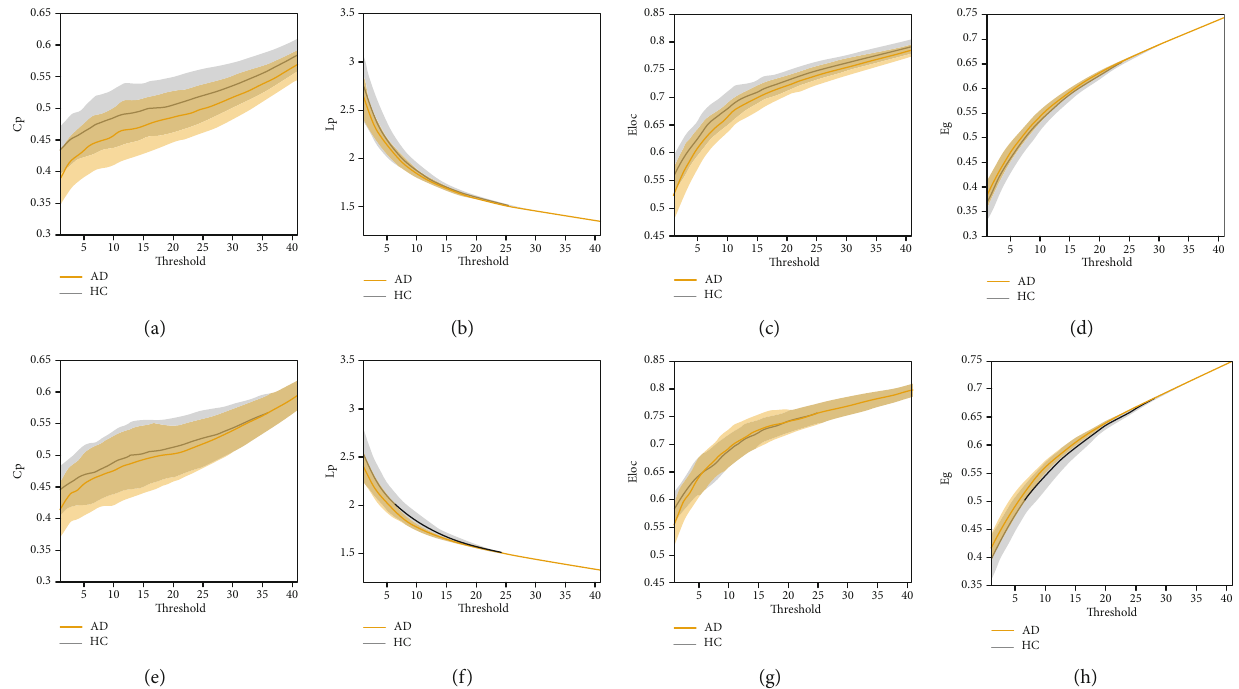
Figure 2: Small-world network parameters of the HCs (grey line) and AD patients (red line) using Pearson correlation (a-d) and sparse L1- norm regularization (e-f). Shaded areas indicate the standard error.